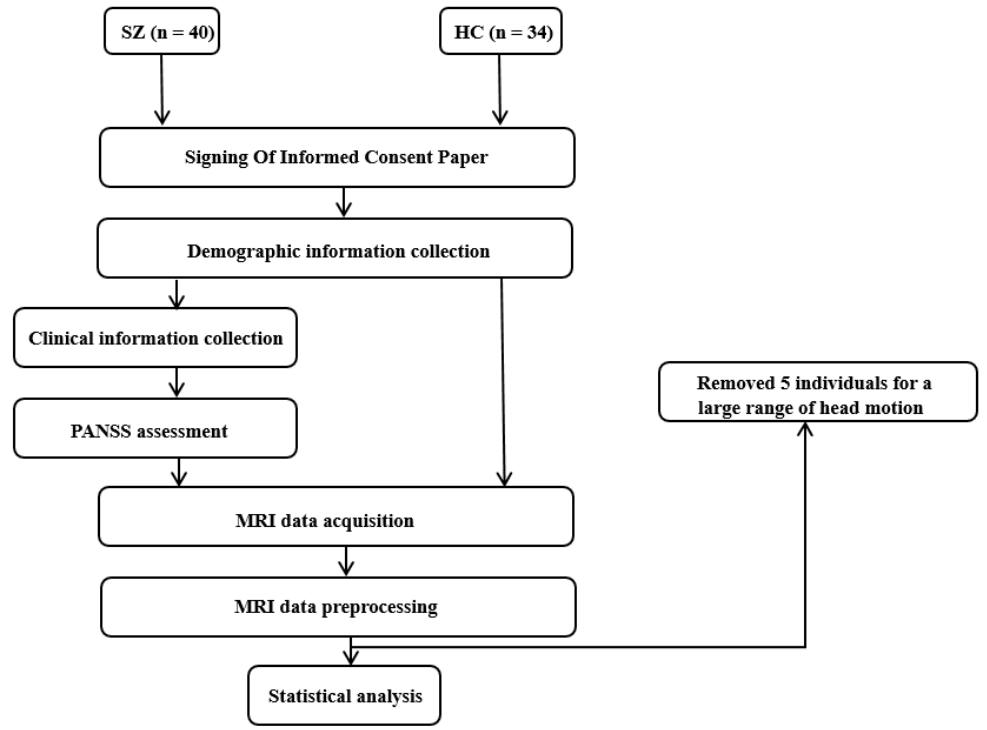
Figure 1. Flow chart of the whole